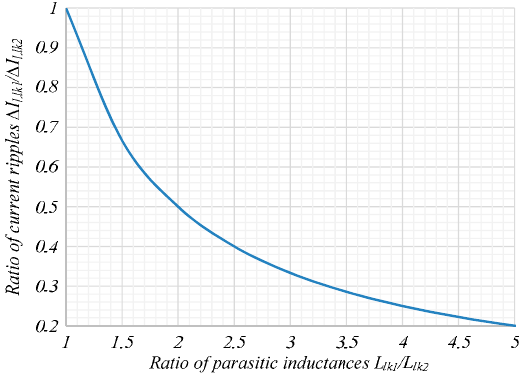
Figure 11. Dependence of the asymmetry of the current ripples in the qZS network coupled